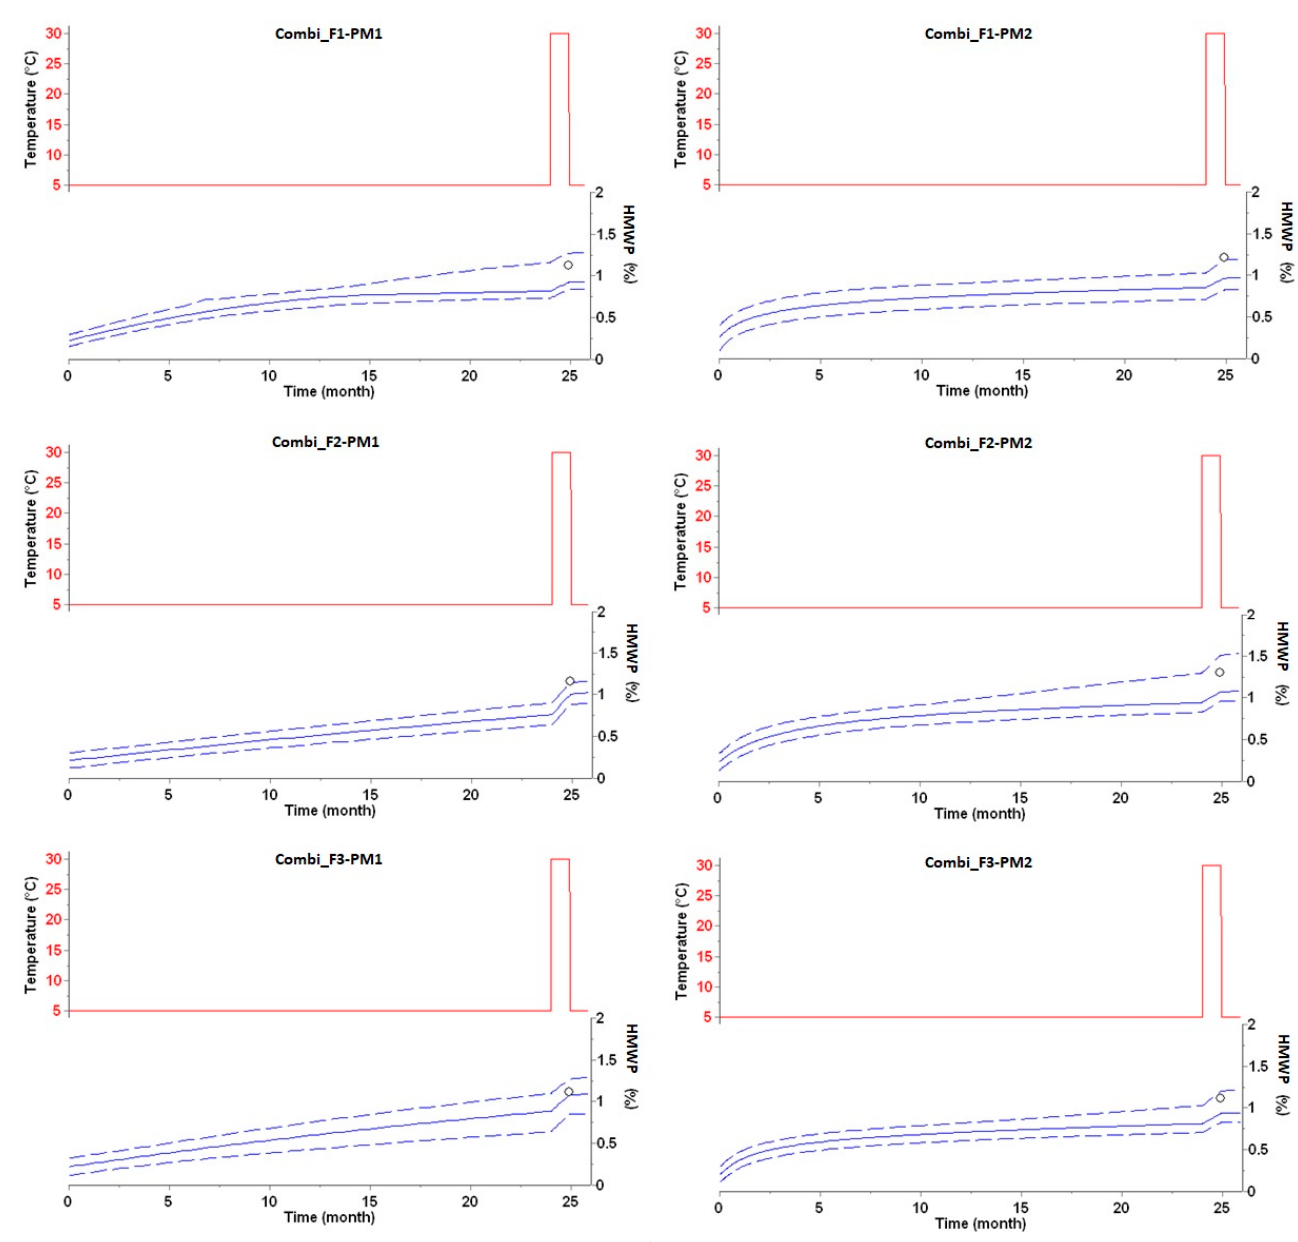
Figure 3. Predictions of high molecular weight protein (HMWP) formation (in %) for three different peptide formulations in two different packaging materials. ( a ) HMWP predictions are displayed as lines for up to 2.5 years at 5 °C (blue), 25 °C (red), 30 °C (green), 37 °C (pink) and 40 °C (cyan). HMWP data used for kinetic modeling are displayed as filled circles. Experimental long-term stability data points, that were not used for model building, are displayed as open circles. These data points beyond 3 months are not uniform for all drug products due to capacity limitations and organizational aspects of the analytical lab. At 5 °C, HMWP predictions are shown with predictive bands representing 99.9% PI (dashed lines). Additional experimental data obtained after two years, and not used for kinetic modeling, are displayed as open circles. ( b ) HMWP of peptides predicted from the best kinetic models during temperature excursions outside the cold chain. HMWP predictions from customized temperature excursions are displayed as lines for 28 days in an incubator set at 30 °C (red, solid line). HMWP predictions are shown with predictive bands representing 99.9% PI (dashed lines). Experimental data determined at the end of temperature excursions, and not used for kinetic modeling, are displayed as open circles.